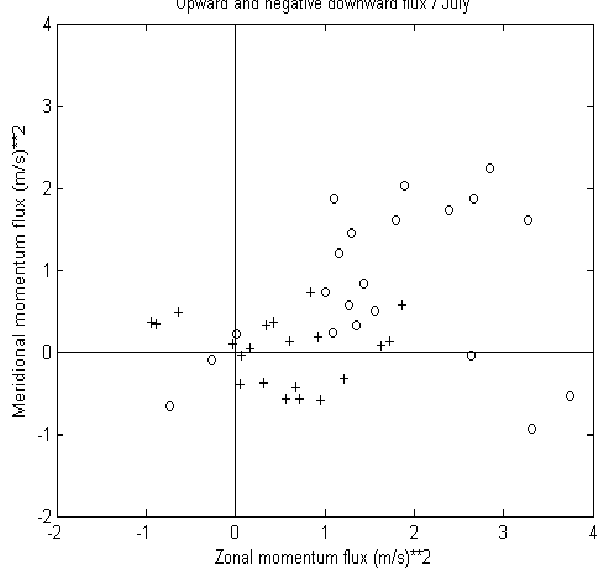
Fig. 8a. Plot of zonal momentum flux vs. meridional momentum flux of upward waves (marked by open circle) and downward waves Fig.8a Plot of zonal momentum flux .vs. meridional momentum flux of upward waves 990 (marked by cross) for November data. All downward fluxes of hor- (marked by open circle) and downward waves (marked by cross) for the izontal momentum were multiplied by − 1 in this plot. month of November data. All downward fluxes of horizontal momentum were multiplied by − 1 in this plot.